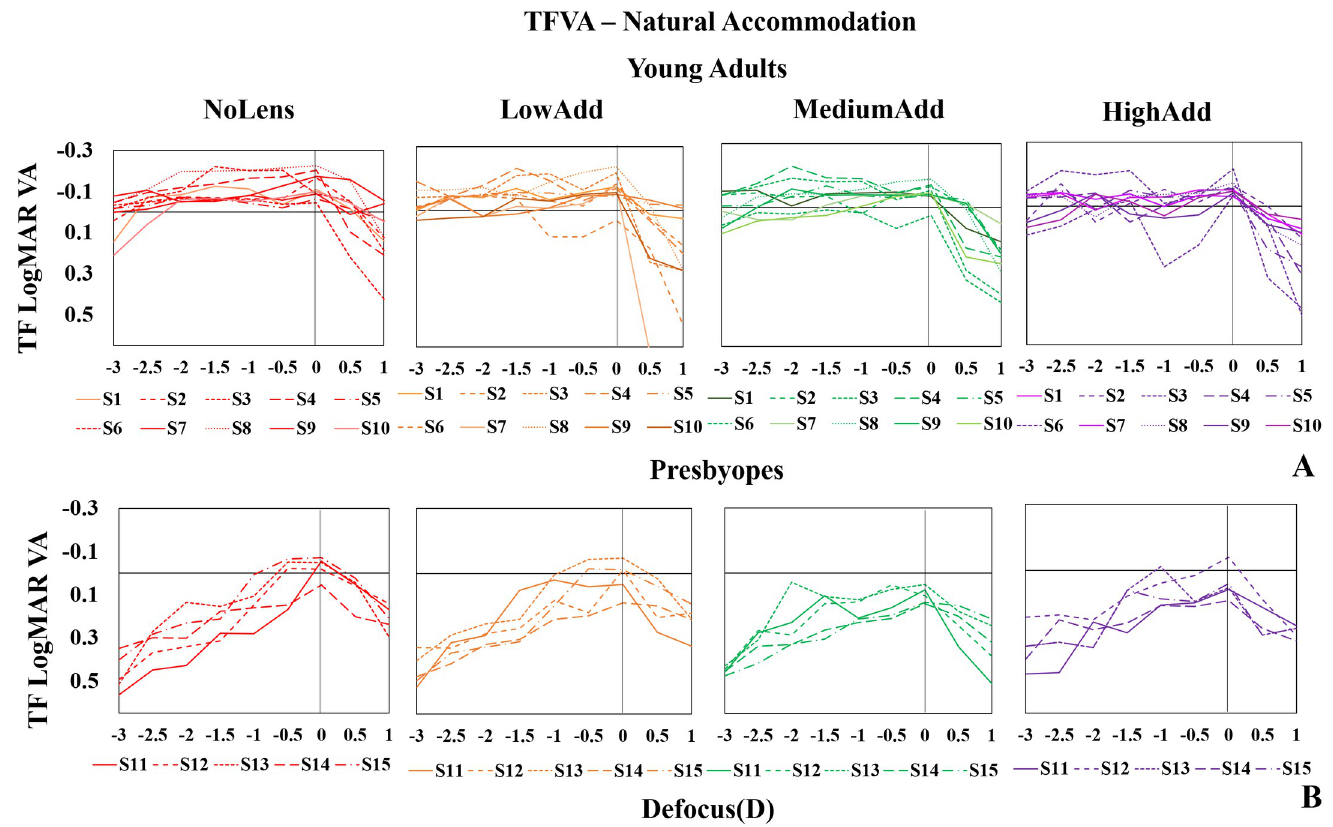
Fig 4. TFVA curves for all subjects and conditions under natural accommodation with natural pupil diameters. (A) young adults (top panels); (B) presbyopes (bottom panels). Conditions from left to right are NoLens, LowAdd, MediumAdd, HighAdd. Lens condition identified by color—Red: NoLens; Orange: LowAdd; Green: MediumAdd; Purple: